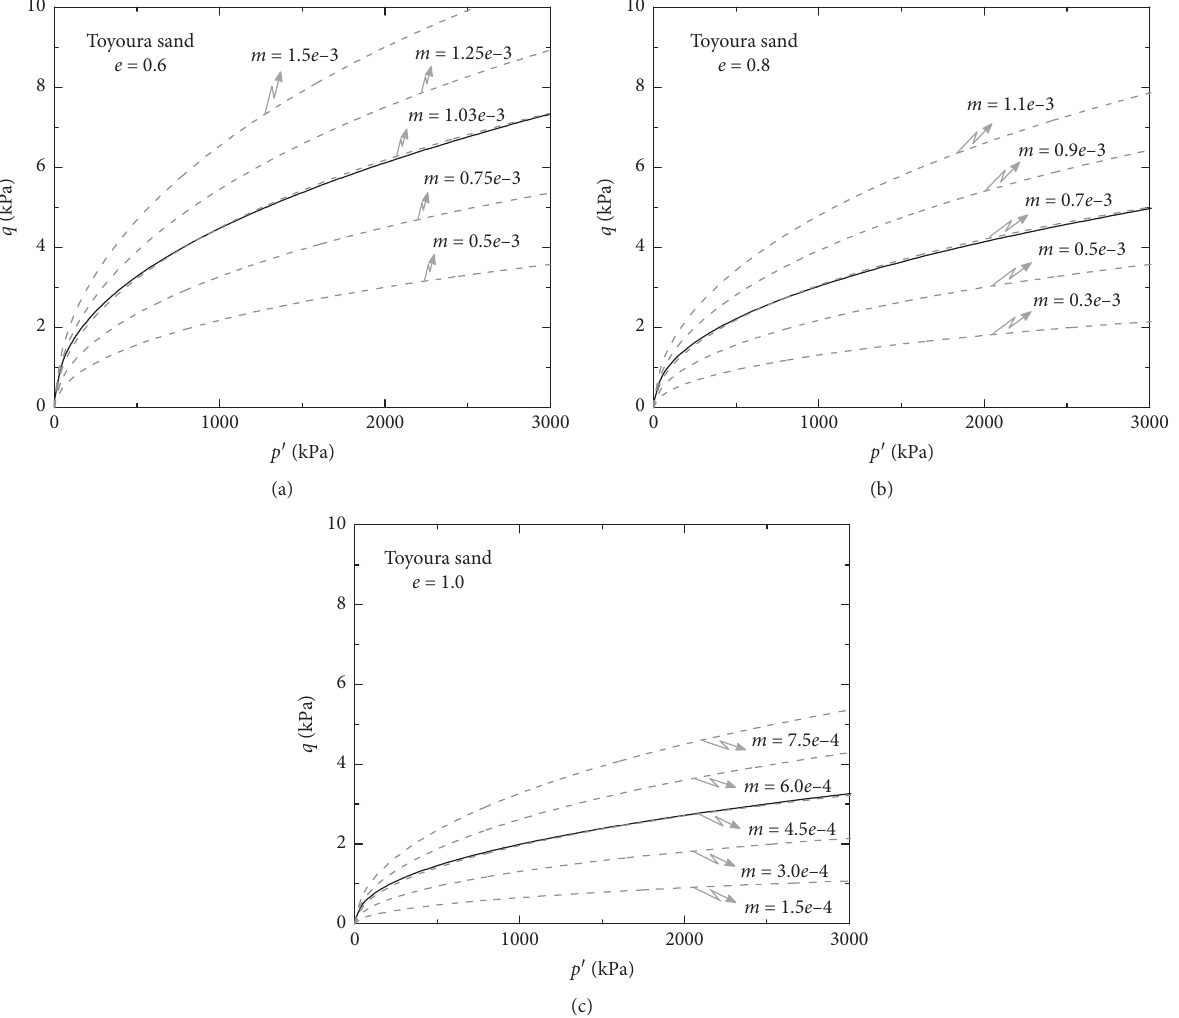
Figure 6: Determination of m of the elliptic yield surface (grey dot lines) based on the proposed yield surface (black solid lines) for Toyoura sand when p 0 is fixed as 20,000: (a) void ratio e � 0.6, (b) e � 0.8, and (c) e �